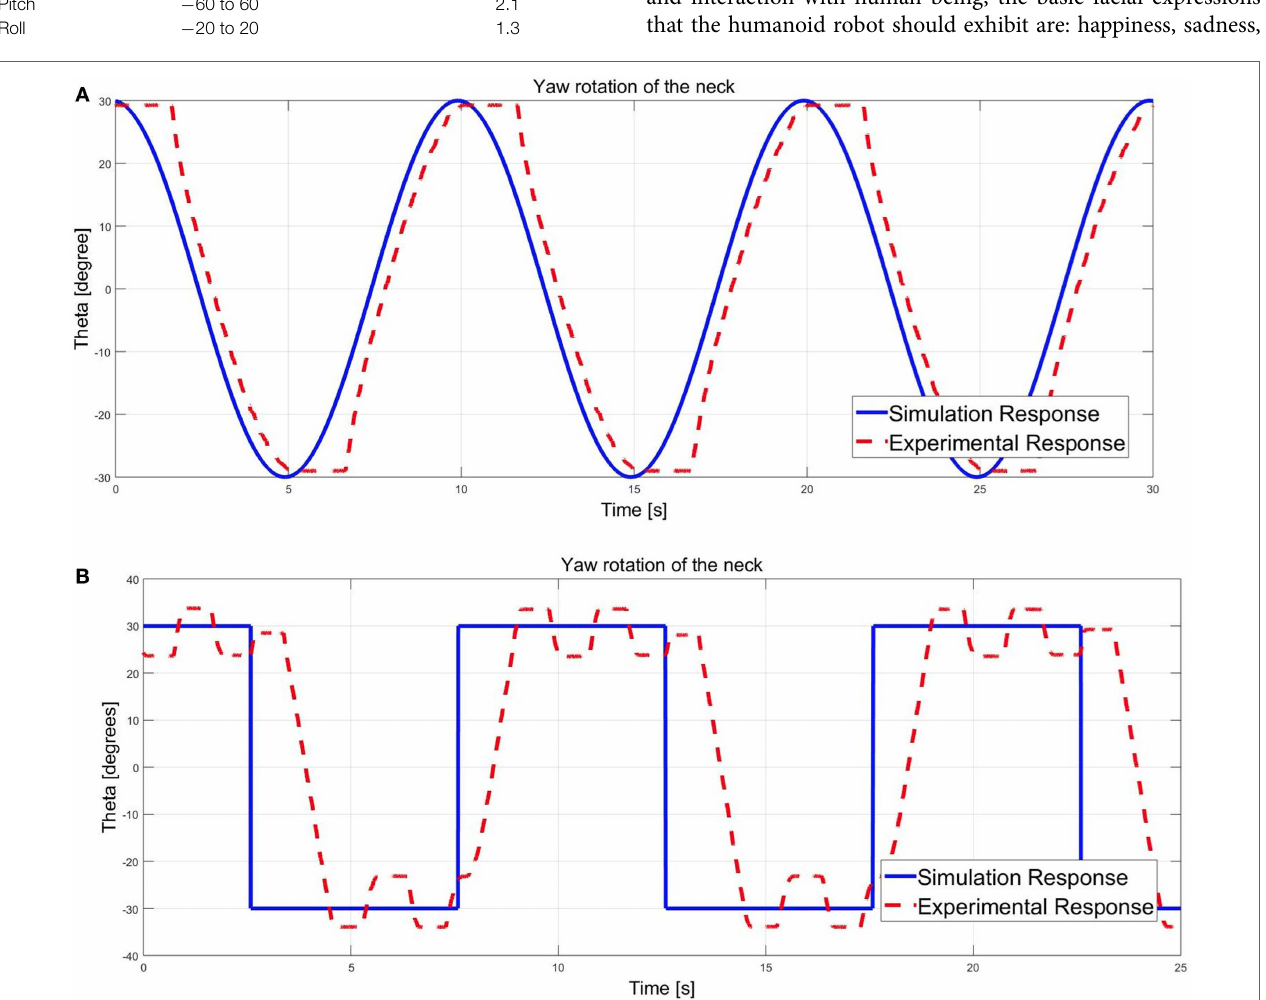
FIGURE 12 | Experimental simulation comparison of the yaw rotation of the neck with (A) sine input (cid:18) = 30° and (B) square input (cid:18) = 30°